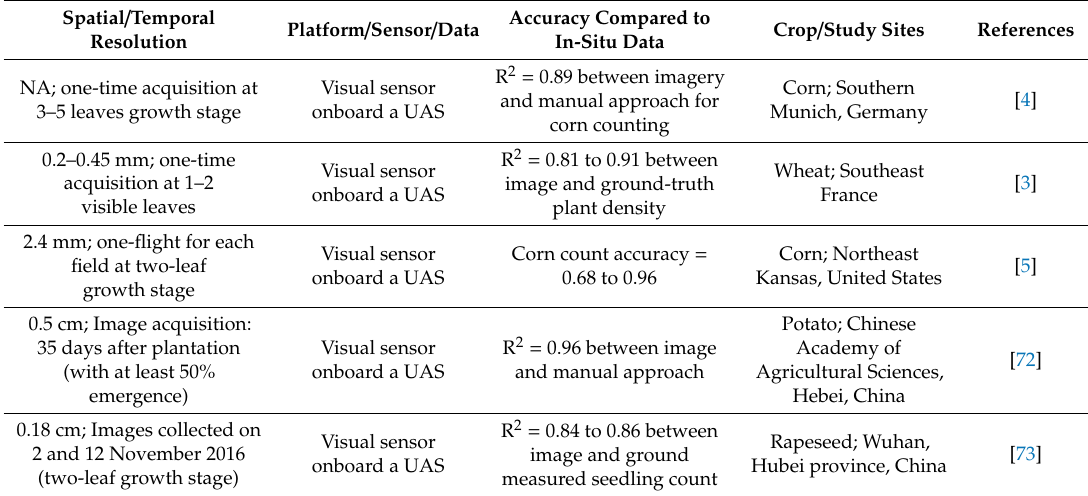
Table 5. Studies conducted for crop emergence assessment using UAS-based visual